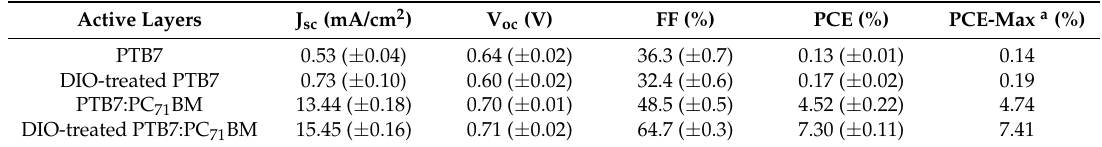
Table 1. Photovoltaic parameters of PTB7-based polymer solar